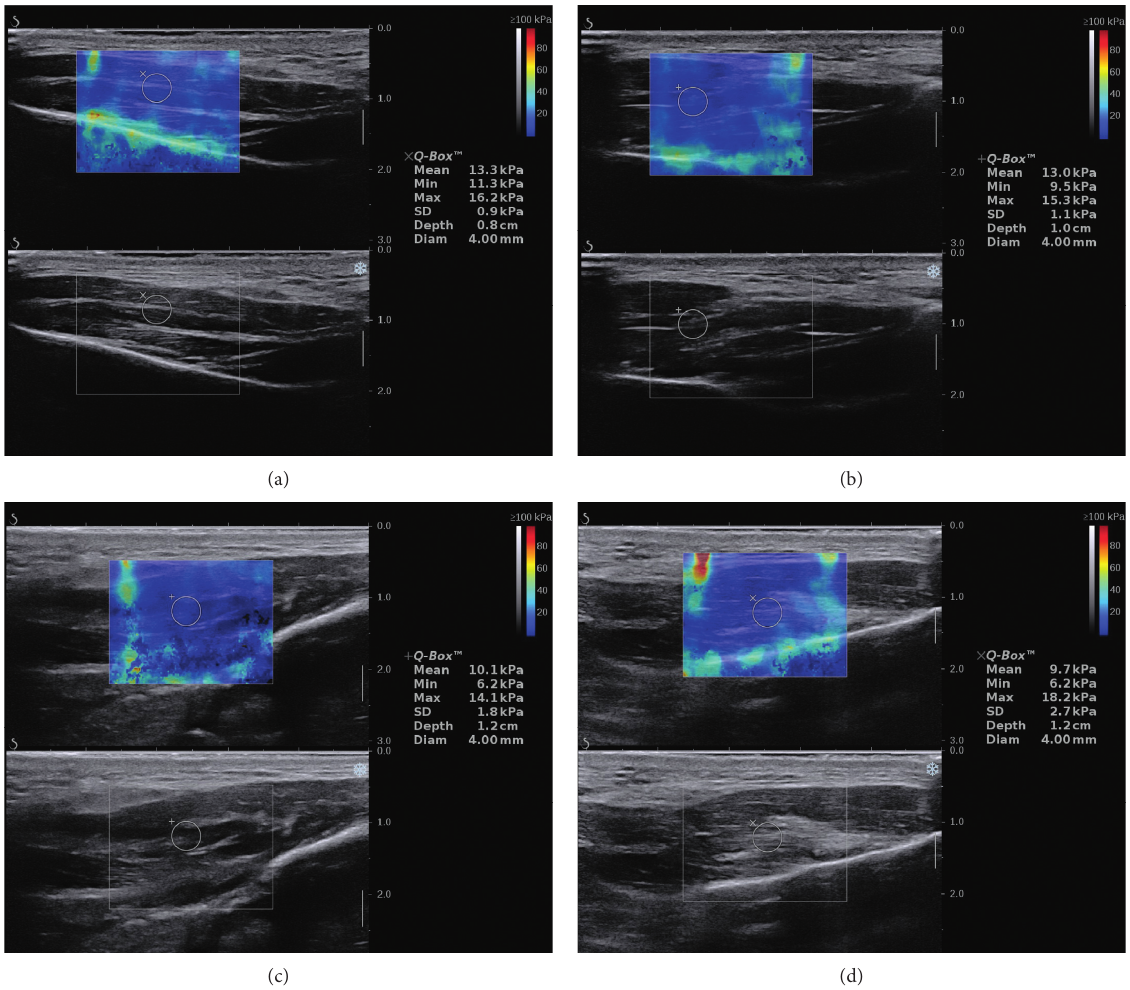
Figure 1: Measurements of elasticity in a 27-year-old female: (a) left masseter before massage; (b) right masseter before massage; (c) left masseter after massage; and (d) right masseter after